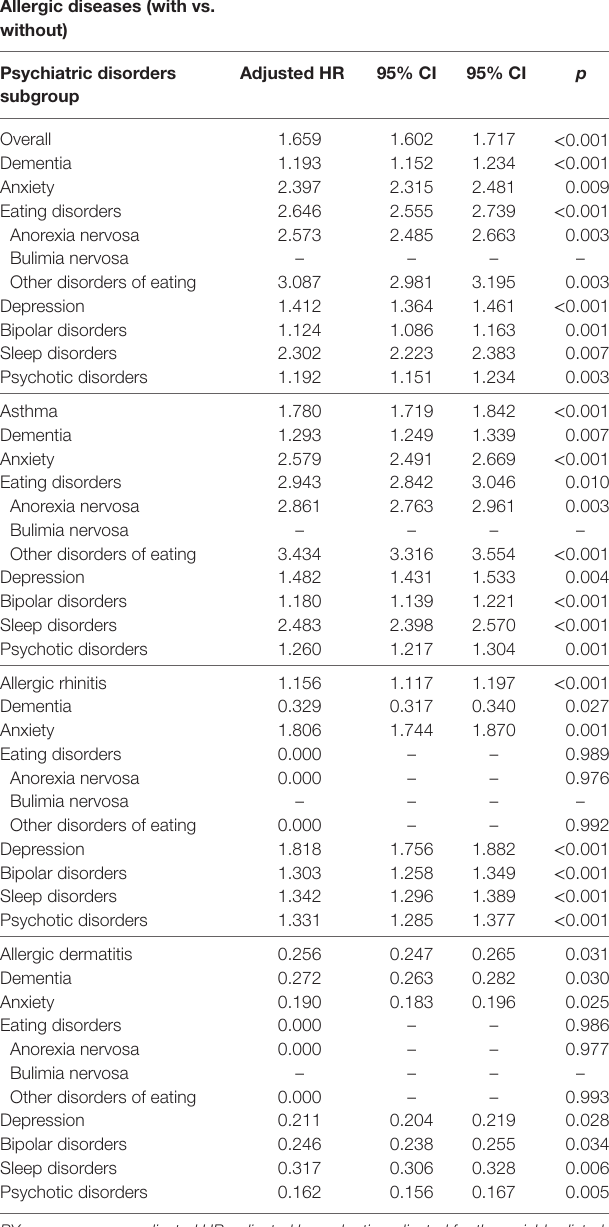
TaBle 3 | Factors of psychiatric disorders subgroup stratified by allergic diseases subgroup by using Fine and Gray’s competing risk model. allergic diseases (with vs.